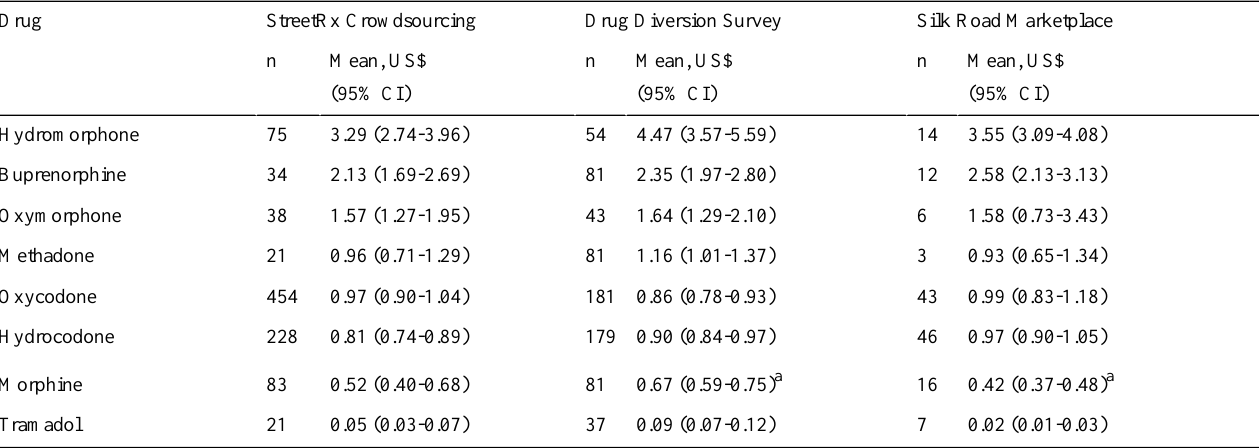
Table 1. Mean black market street prices and equianalgesic potency, US dollars per milligram, from online and law enforcement data sources, United States, 2012.